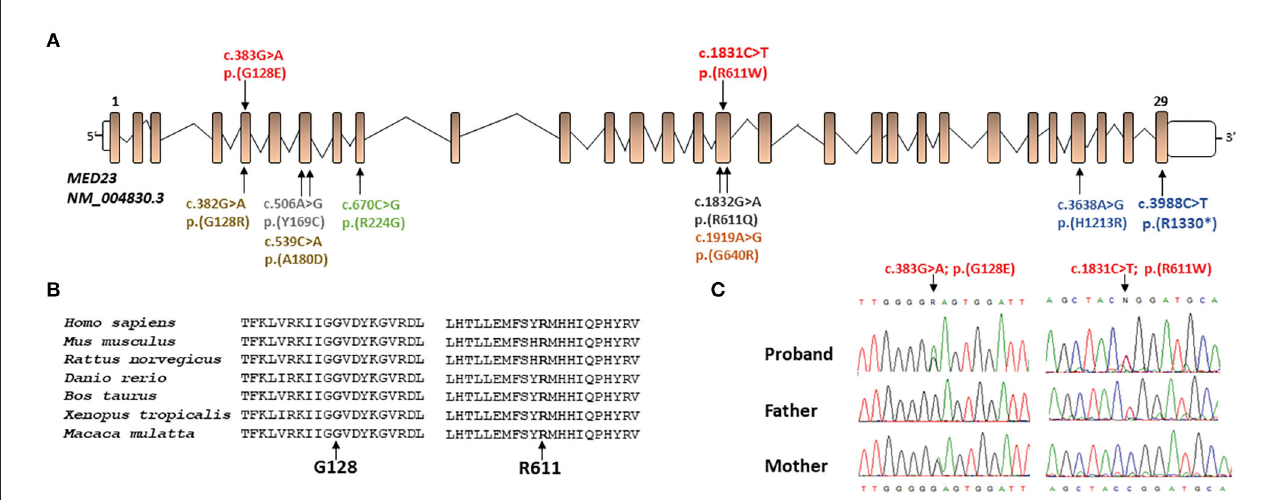
FIGURE2 (A) Schematic representation of the MED23 transcript ( NM_004830.3 ) and location of all mutations present in literature (in black and gray mutations related to milder phenotypes, in orange, yellow, green, and blue the ones related to more severe phenotype) and novel mutations described in this report (in red). (B) Protein sequence alignment of human MED23 with its orthologs and conservation of the affected residues (from the top: NP_004821.2; NP_001159888.1; XP_008756834.1; XP_021324080.1; XP_024852307.1; XP_002936353.2; and XP_014992795.1). (C) The MED23 electropherograms at the genomic DNA level of all family members showing the novel MED23 mutations identified by